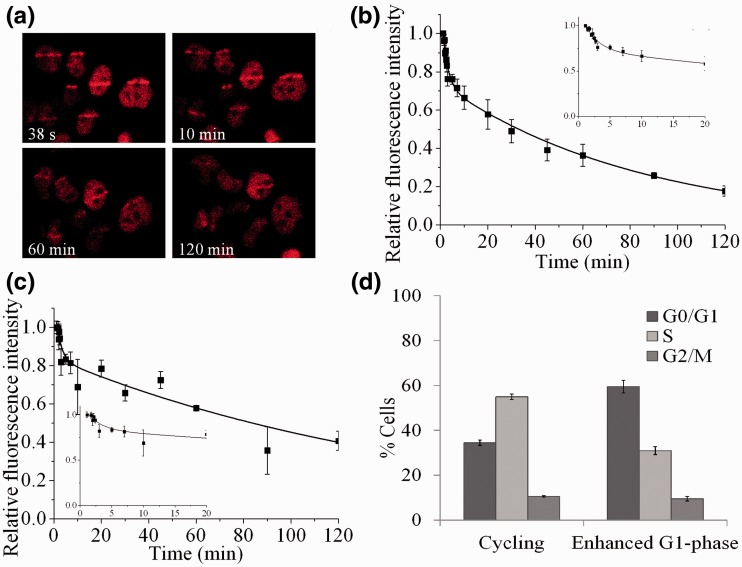
Dependence of the recruitment and loss of fluorescence intensity of Ku80-EGFP in (a) and (b) exponentially growing and (c) serum-starved cells on time following NIR microbeam irradiation with 730 nm photons (at a power of 10 mW through a ×60 objective). For real-time analysis, each point represents the relative fluorescence intensity normalized to the intensity at ‘zero time’ following irradiation and maintaining the cells at 37°C. The kinetic analysis to obtain the best fit to the experimental data are shown as solid lines and described in the Materials and Methods section. The insets represent the data expanded to show the first 20 min in more detail. (d) Flow cytometry analysis to show the cell cycle distribution of exponentially growing and serum-starved cells.